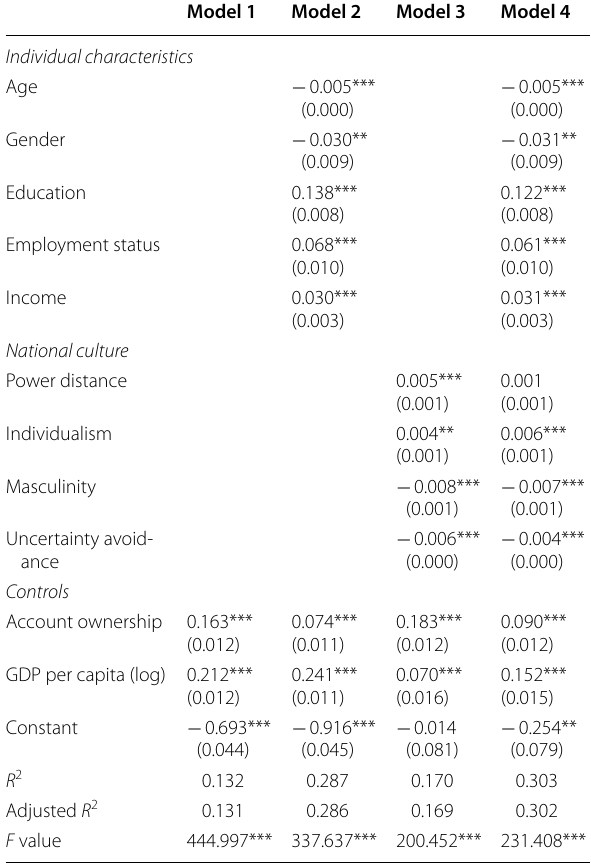
Table 3 Regression results